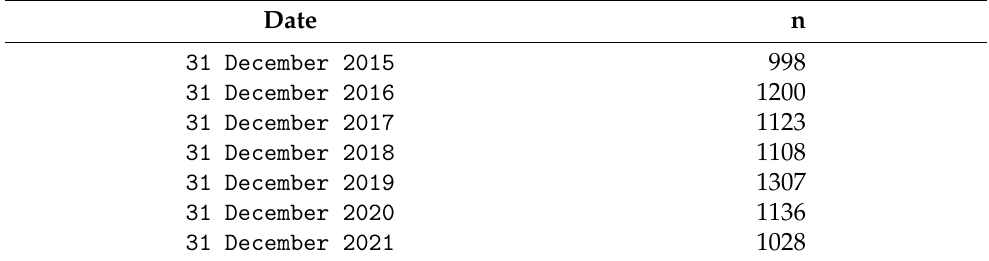
Table 2. Number of patients who remain in SWL annually in the ENT unit of